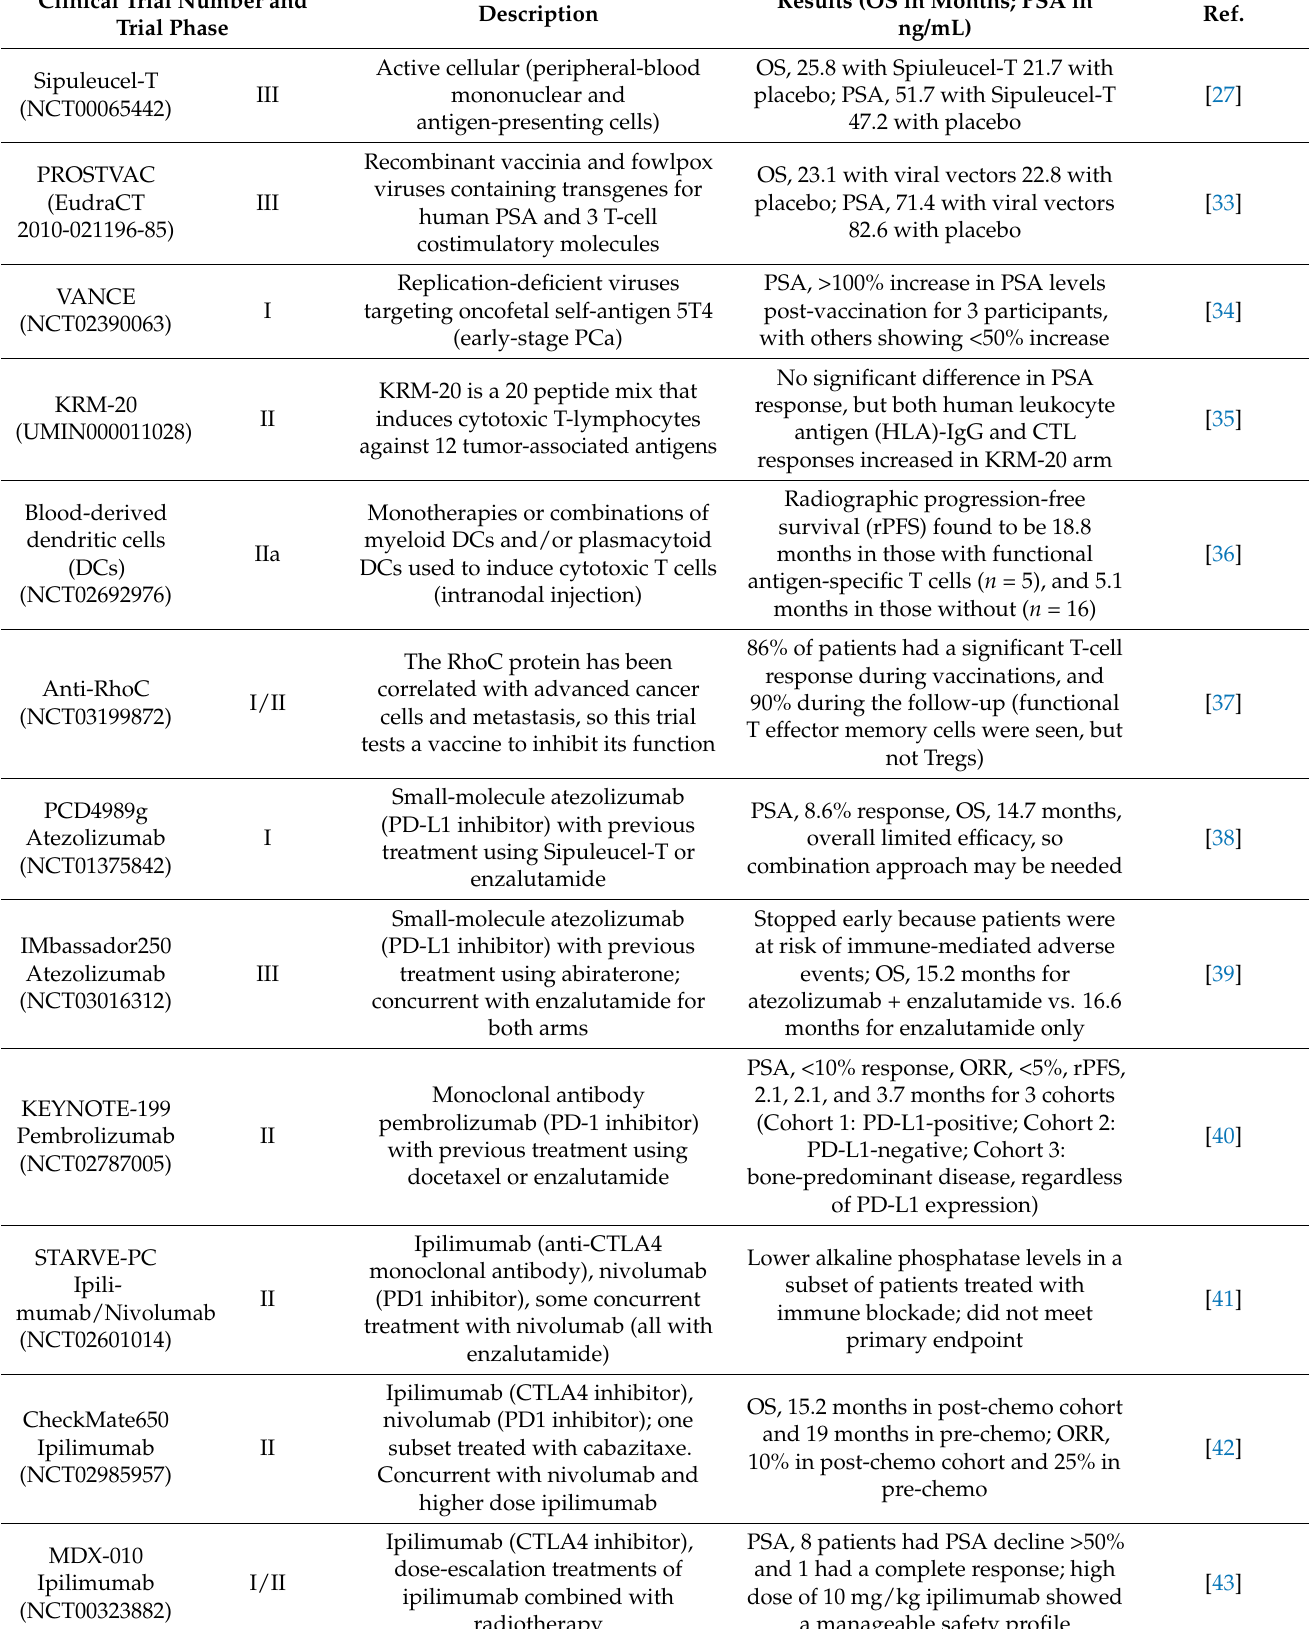
Table 1. Completed vaccine and immune checkpoint inhibitor clinical trials for